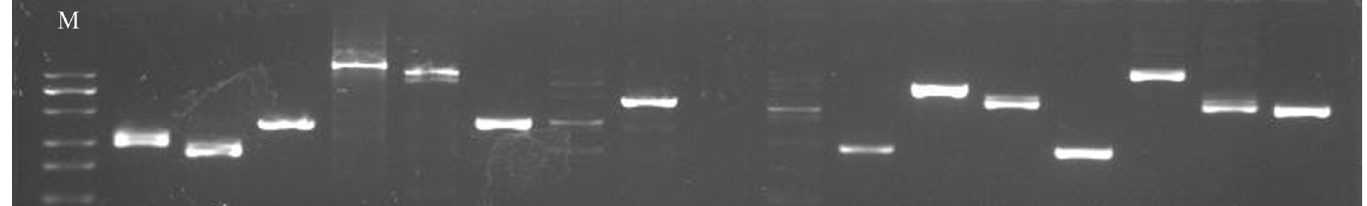
Fig 6. Photograph of PCR amplification results for SSR markers in licorice. The first line is the DNA ladder. The subsequent lines are the PCR products generated using different primers.